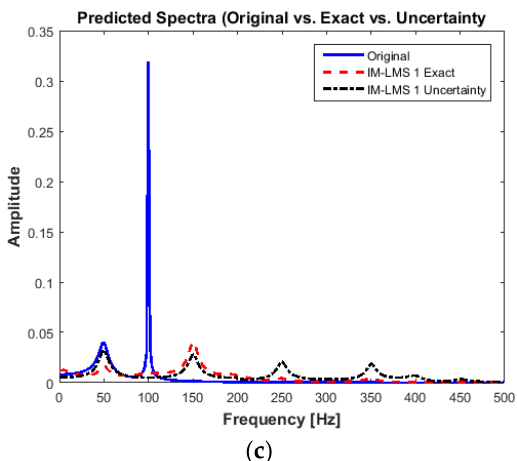
Figure 5. Simulation results in the time domain (single sinusoid at 100 Hz) with LMS and internal model LMS 1 methods. ( a ) With exact model (top) and with uncertainty (bottom); ( b ) comparison of estimation error; ( c ) predicted spectra.